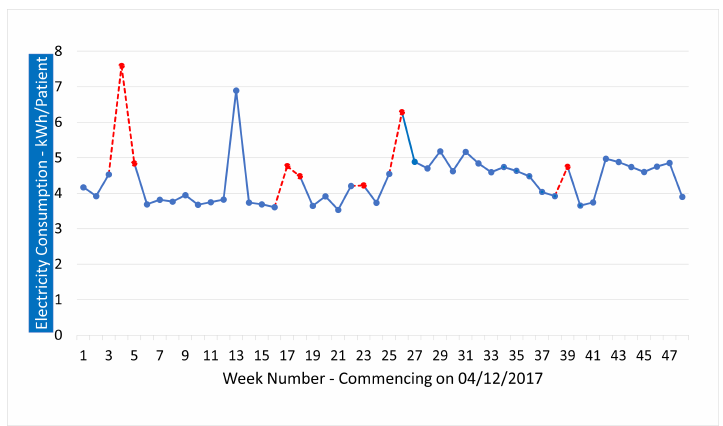
Figure 7. Electricity consumption per patient in the cardiac catheter suite. The dashed red lines in Figure 7 represent the highest recorded weekly electricity consumption per patient, in the weeks with bank holidays in them, most of which are above average (4.44